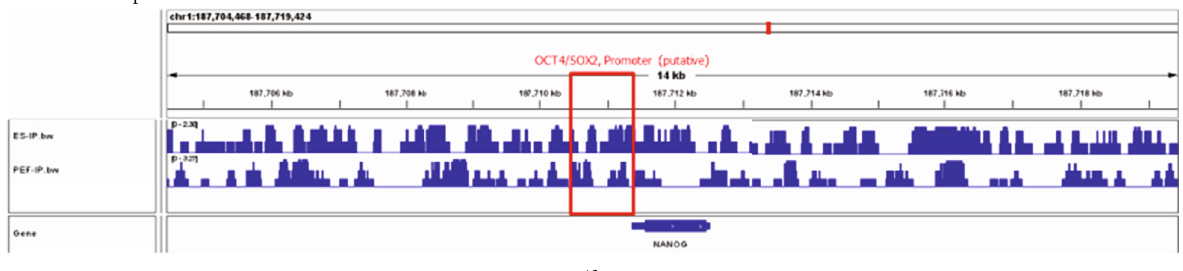
Figure 7: Genomic snapshots of porcine OCT4 ChIP-seq nearby pluripotent markers OCT4 , SOX2 , and NANOG in porcine embryonic stem cells and embryonic fi broblasts. (a) 9700bp sequence around OCT4 . (b) 25kbp sequence around OCT4 . (c) 4961bp sequence around SOX2 . (d) 10 kbp sequence around SOX2 . (e) 5160 bp sequence around NANOG . (f) 14 kbp sequence around NANOG